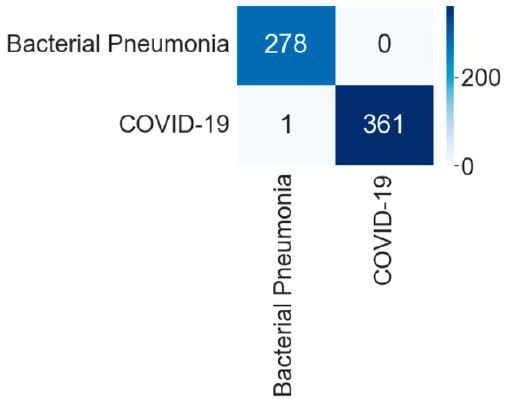
Figure 12. Confusion matrix for the classification into COVID-19 and bacterial pneumonia by DenseNet201.